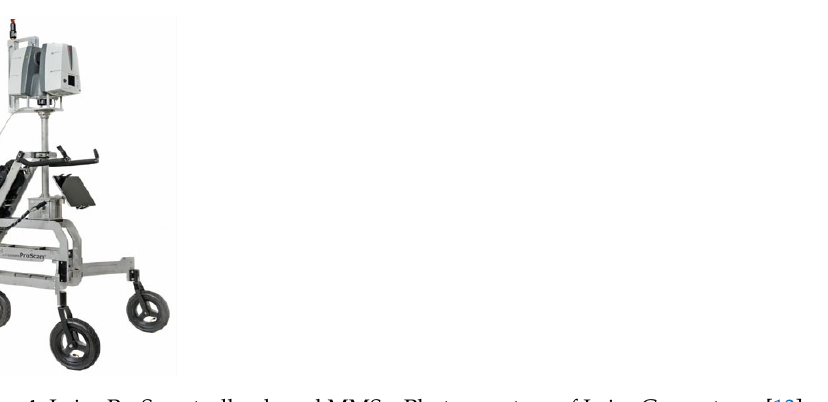
Figure 4. Leica ProScan trolley-based MMSs. Photo courtesy of Leica Geosystems [13].